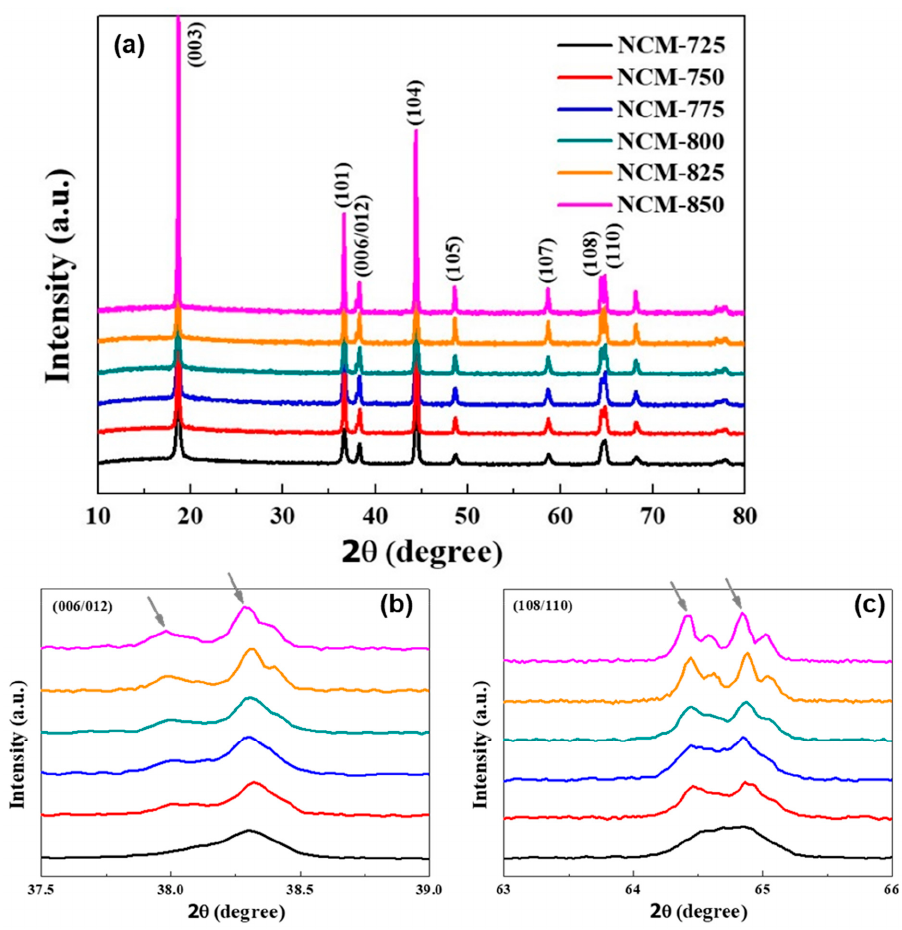
Figure 3. Powder XRD patterns of ( a ) SNCM at different calcination temperature; and enlarged XRD patterns of ( b ) (006)/(012) and ( c ) (108)/(110) diffraction peaks.